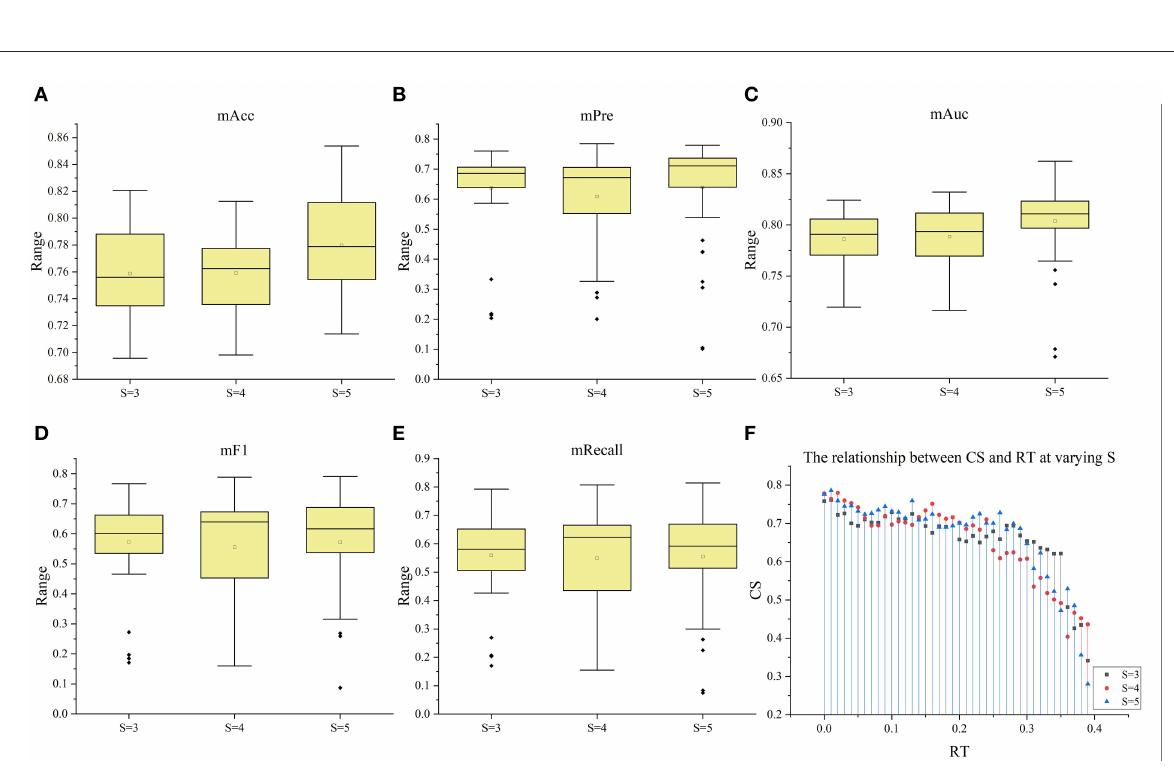
FIGURE9 The box plots of the five index under the three situation (S = 3–5). (A–E) The box plots of mACC, mPre, mAuc, mF1, and mRecall in the three situations, respectively. (F) The relationship between CS and RT at varying